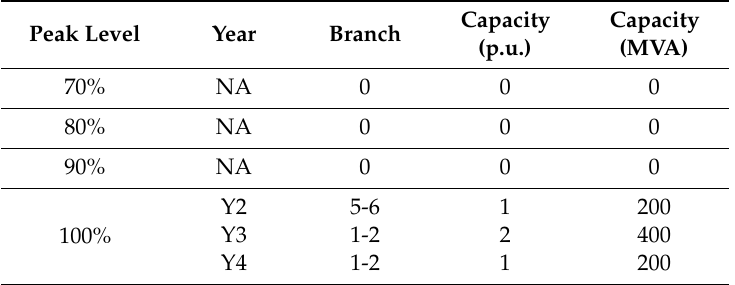
Table 9. Substation upgrades required for each studied scenario. Table 10. Feeder upgrades required to ensure the power supply in each scenario (70%, 80%, 90%, and the main case